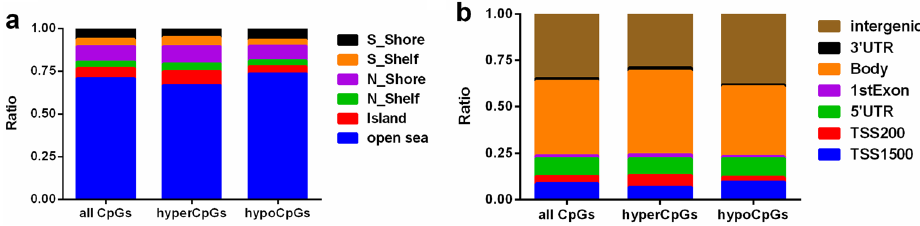
Figure 3. Stacked bar plots depicting the percentage of differentially methylated CpG sites according to their CpG island-related or gene location-related status. (a) Percentage of dmCpGs according to their location in relation to CpG islands. ( b ) Percentage of dmCpGs according to genic location.